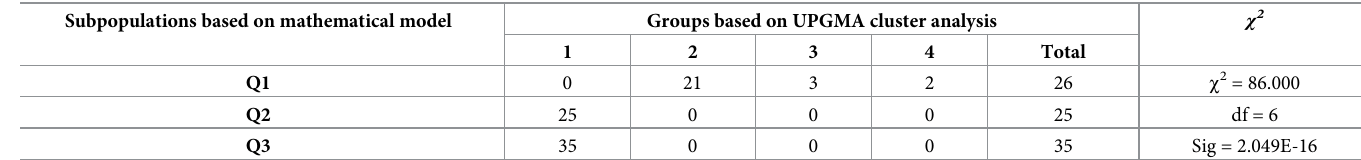
Table 4. Correlations between subpopulations of P . armeniaca var. a nsu based on mathematical modeling and groups based on UPGMA cluster analysis. Subpopulations based on mathematical model